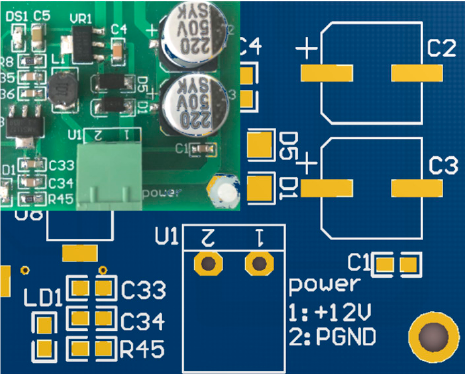
Figure 11. Power circuit of the main fuel regulation control system.